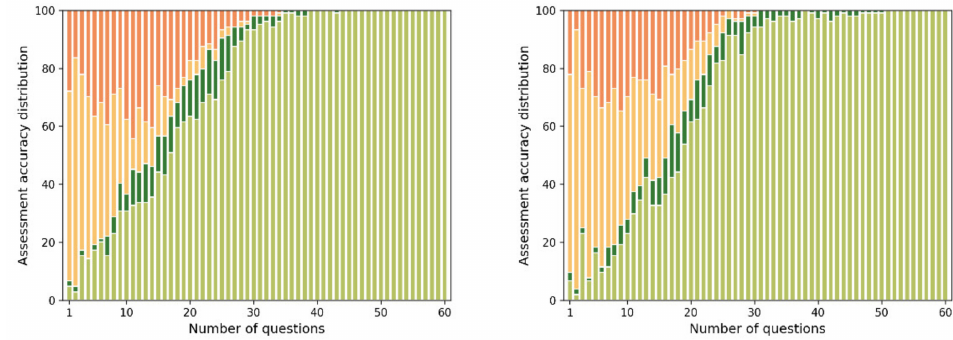
Figure 6. Distribution of students assessed for topic precision for UCB, left, and Elo-bandit, right. Where red <1%, orange 1–50%, dark green 50–99%, and green >99%